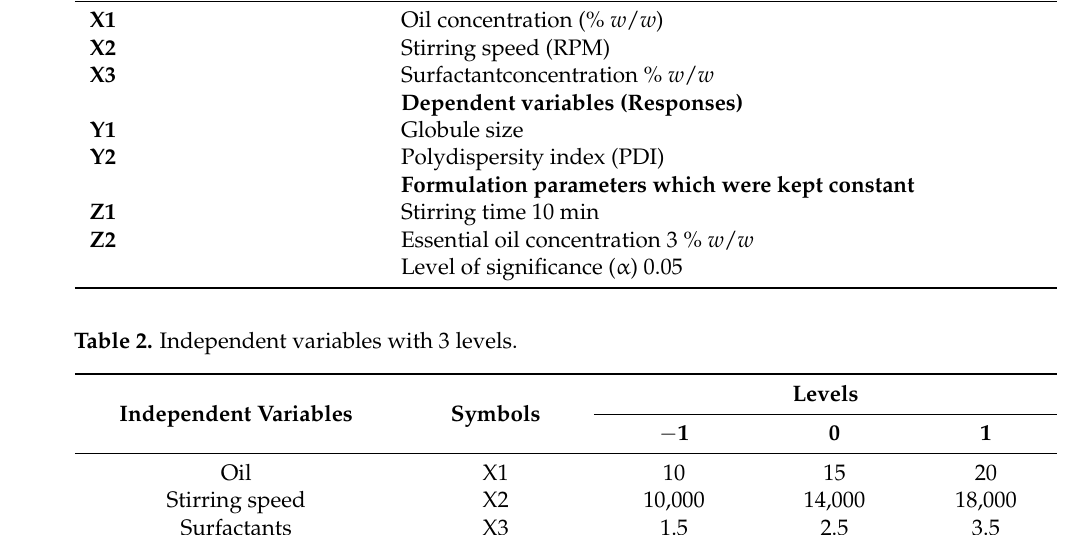
Table 1. Independent factors, dependent factors (responses) and parameters. S.N